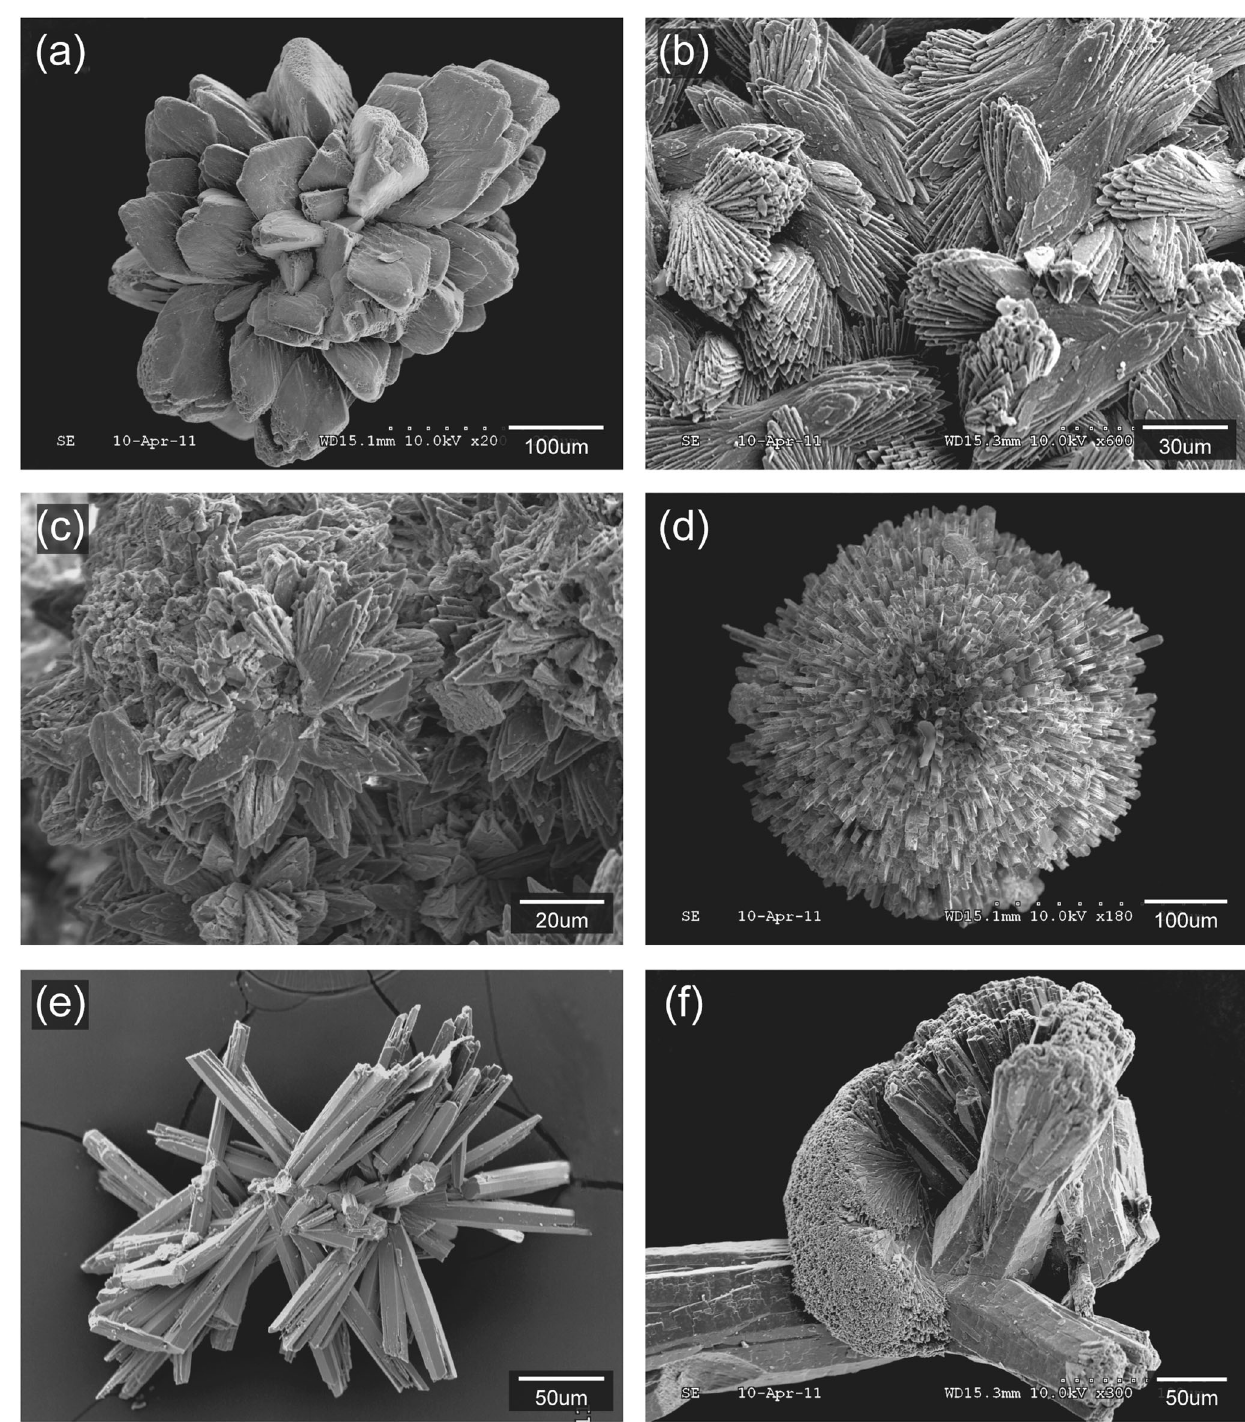
Fig. 2 Scanning electron microscopy (SEM) photomicrographs showing a variety of calcite and aragonite ultrastructures of authigenic carbonates. a Radially grown calcite lumps with foliated layers, b randomly oriented, foliated calcite, c radially oriented, foliated calcite, d spherulitic aragonite, e randomly oriented aragonite crystals with square-ended terminations, and f two stages of aragonite growth. Note that larger aragonite rods are overgrown by fi ner spherulitic fi brous